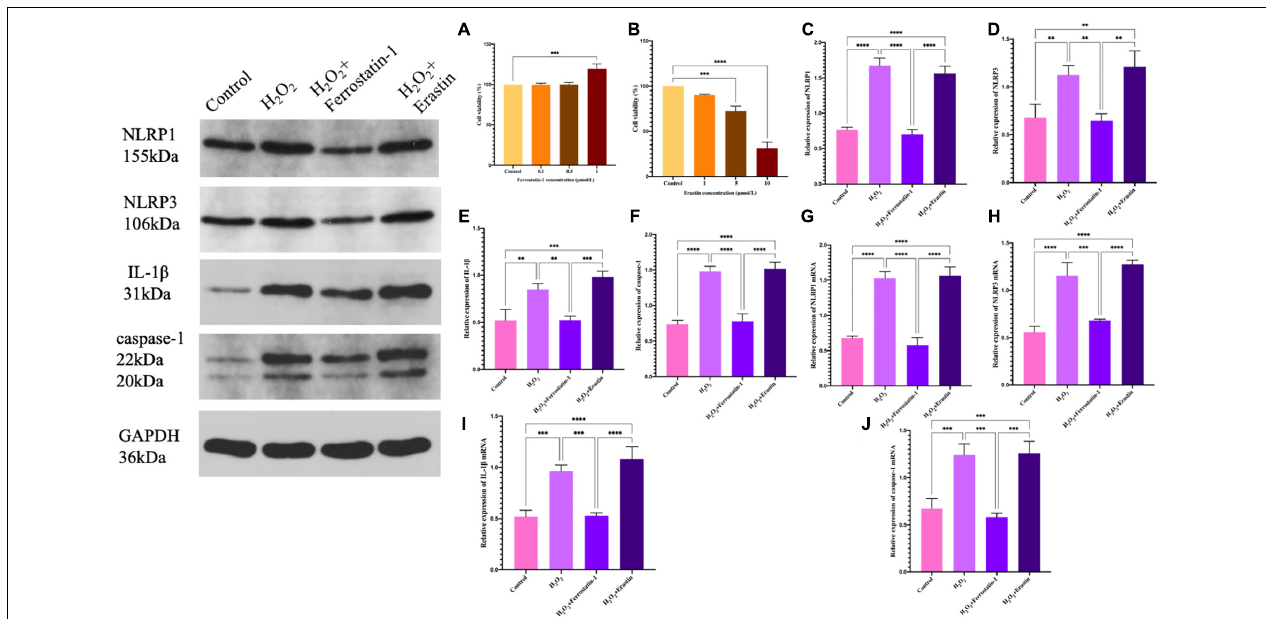
FIGURE 4 | (A) The effect of ferrostatin-1 concentration on HTR-8/SVneo cell activity, as determined by the CCK-8 assay. (B) The effect of erastin concentration on HTR-8/SVneo cell activity, as determined by the CCK-8 assay. (C–F) Inflammasome-related protein expression in HTR-8/SVneo cells was detected by western blot. (C) NLRP1, (D) NLRP3, (E) IL-1 β , and (F) caspase-1. (G–J) mRNA expression in HTR-8/SVneo cells was detected by qRT-PCR. (G) NLRP1, (H) NLRP3, (I) IL-1 β , and (J) caspase-1 (* P < 0.05, ** P < 0.01, *** P < 0.001, and **** P < 0.0001). Values represent means ± SD, n = 3 per